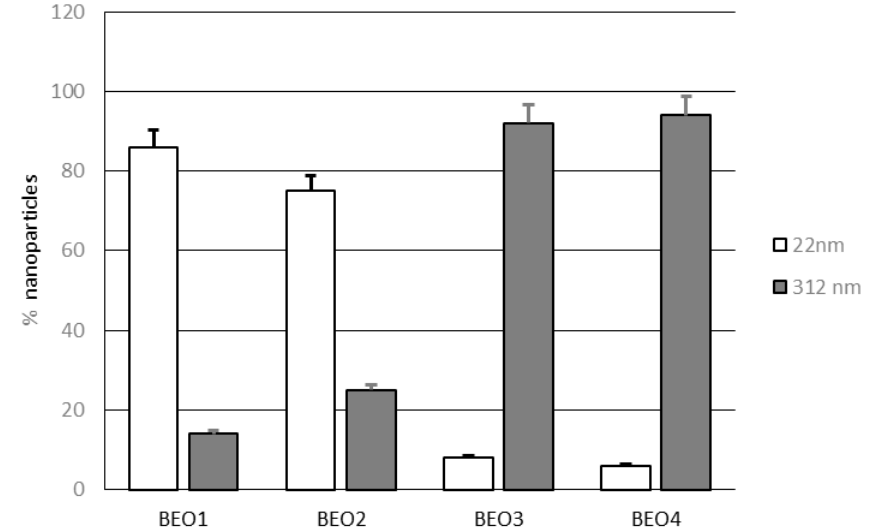
Figure 1. Percentages of nanoparticles with different mean size (22 and 312 nm) in lipid nanoparticles BEO1–4.